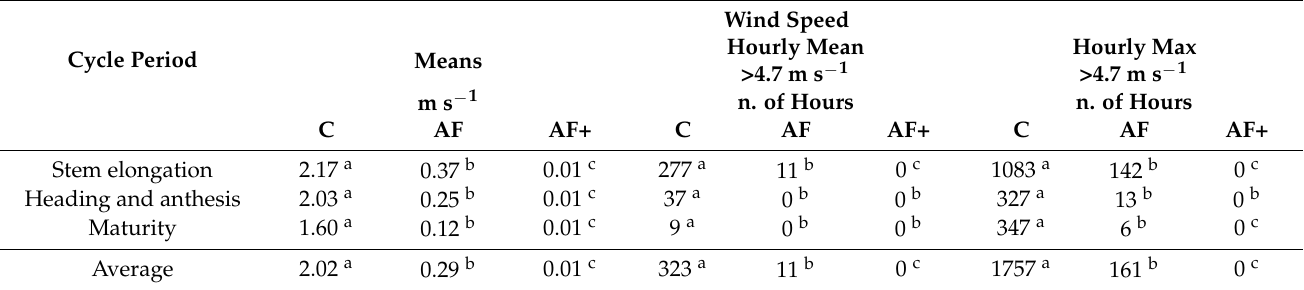
Table 1. Average wind speed and number of hours with means and maximum wind speed > 4.7 m s − 1 (17 Km h − 1 ) recorded in C, AF and AF+ treatments within 2016–17 growing season at stem elongation (from sowing to 7 April), heading and anthesis (from 8 April to 10 May) and maturity (from 11 May to harvesting). Within the same cycle period, means with different letters are significantly different according to the Tukey’s HSD test ( p ≤